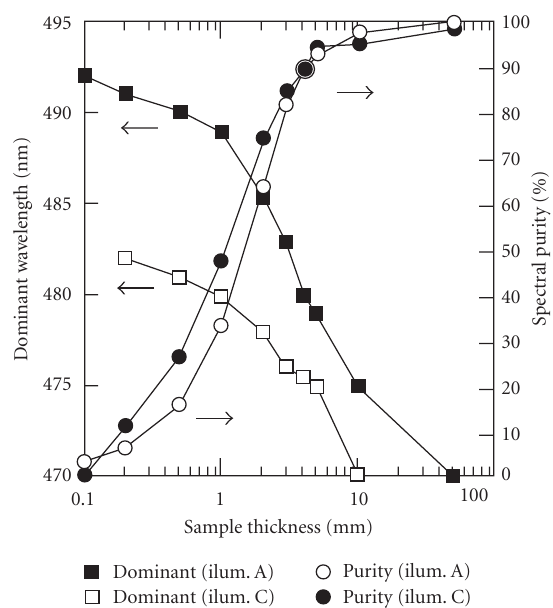
Figure 4: Dominant wavelength (in nm) and spectral purity (in %) as function of sample thickness (in mm) for blue